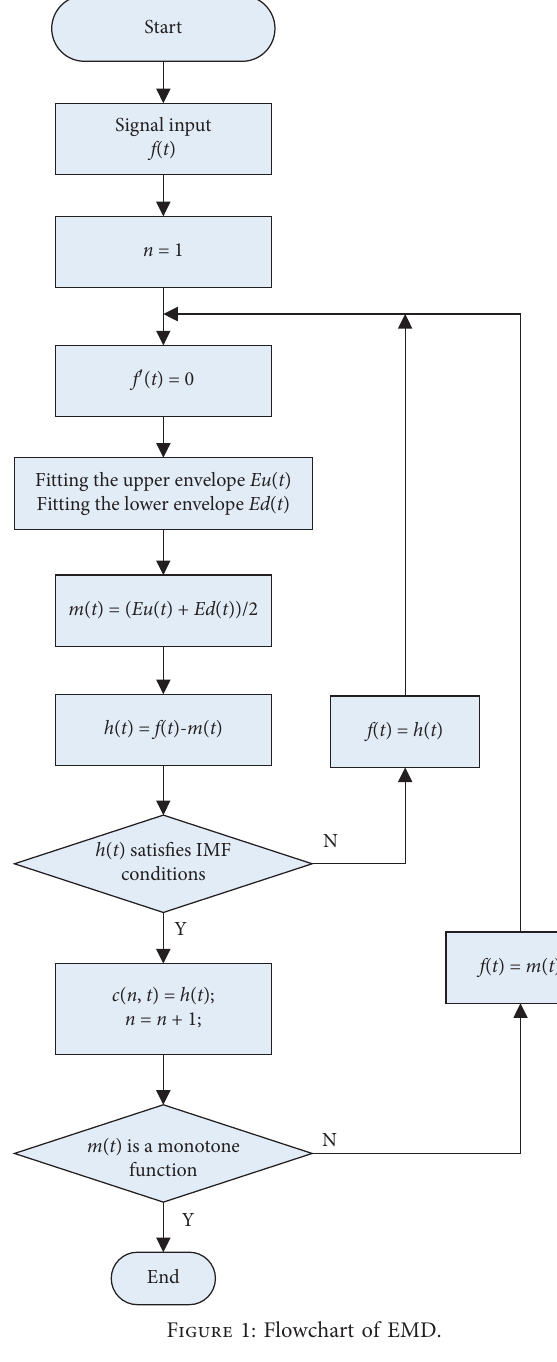
Figure 1: Flowchart of